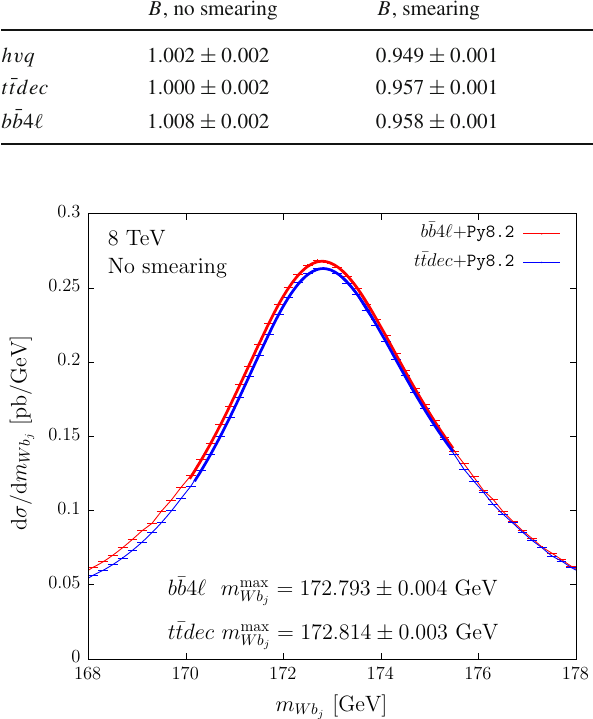
Fig. 8 d σ/ dm Wb distribution obtained with the b ¯ b 4 (cid:4) and t ¯ tdec gen- j erators interfaced with Pythia8.2 , for m t = 172 . 5